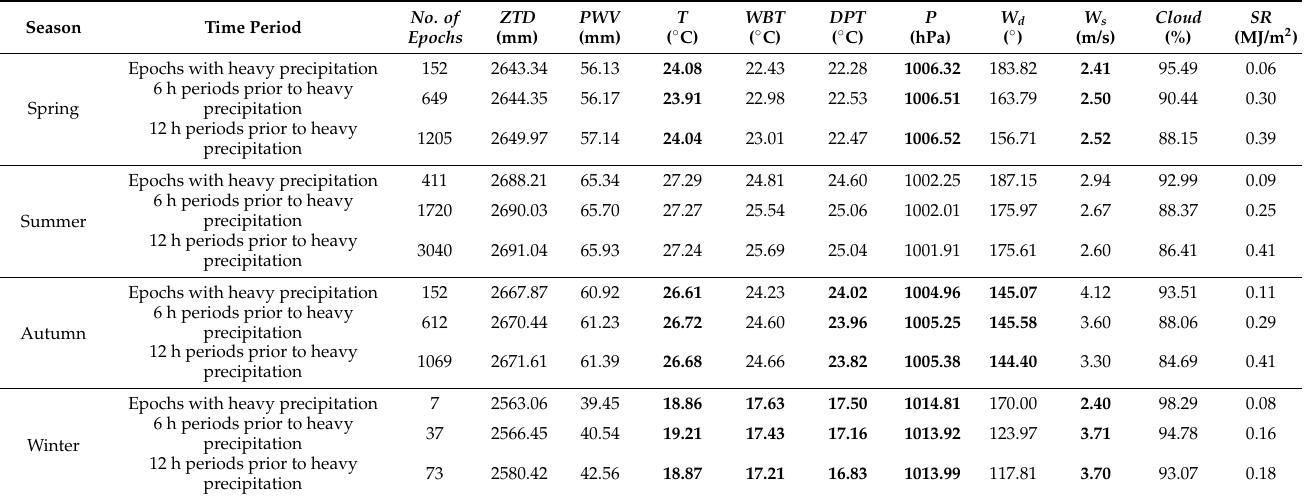
Table 9. Comparison of mean values obtained at the 6 h and 12 h periods prior to heavy precipitation in the four seasons over the 12-year period